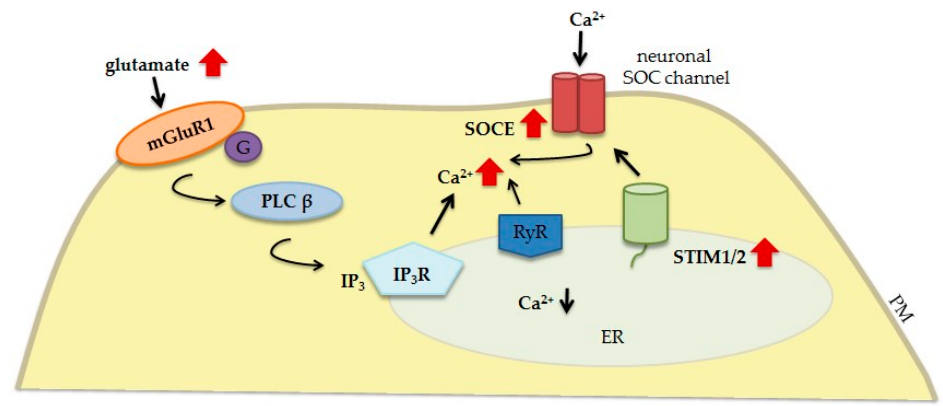
Figure 3. Contribution of neuronal STIM proteins and glutamate receptors to Ca 2+ signaling dysregulation in TBI. The elevation of glutamate release leads to the excessive stimulation of glutamate receptors (e.g., mGluR1). mGluR1 couples to G α -protein, which activates PLC β and induces the formation of IP 3 that interacts with IP 3 Rs, causing the release of Ca 2+ from ER stores. mGluR1 also contributes to RyR-mediated Ca 2+ leakage, resulting in lower ER Ca 2+ levels, which in turn activate STIM proteins and promote SOCE that contributes to Ca 2+ overload. Solid black arrows represent the interaction mechanisms; red solid arrows symbolize increased expression/concentration.